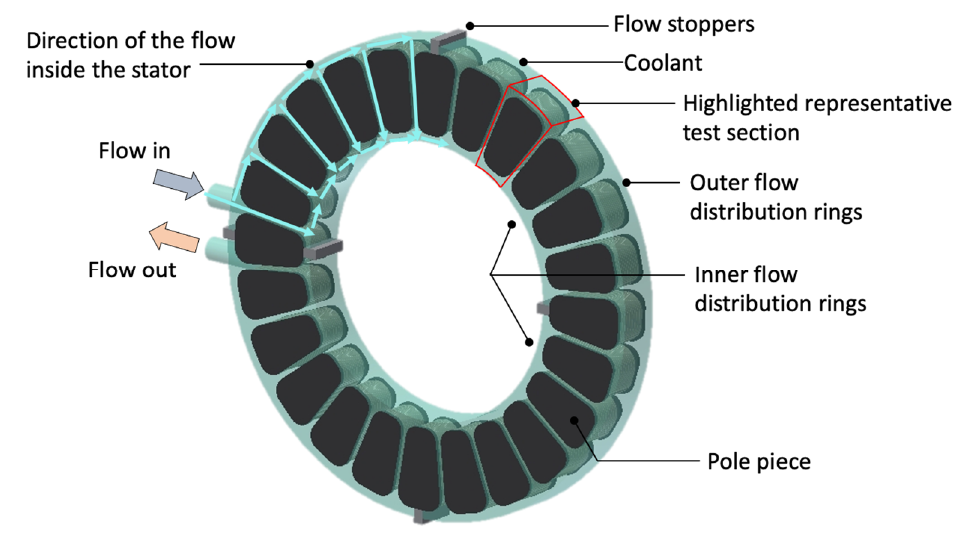
Figure 1. Schematic of the direct liquid-cooled stator used as a test case. Highlighted section: pole piece channel used for modelling and testing.